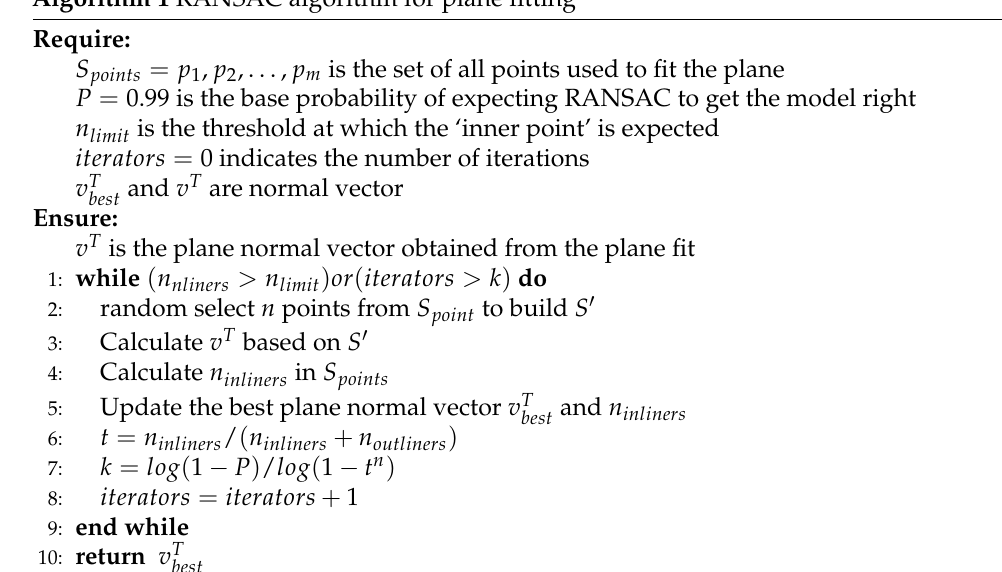
Algorithm 1 RANSAC algorithm for plane